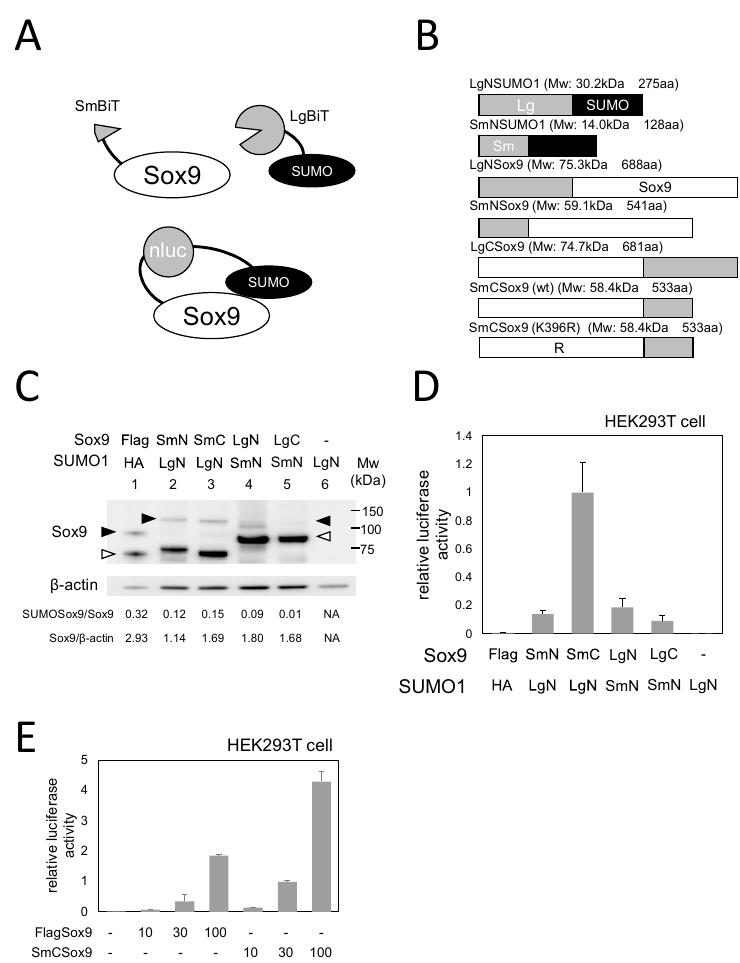
Figure 1. Generation of Small Ubiquitin-like Modifier-Sox9 (SUMO-Sox9) reporter. ( A ) Schematic diagrams of the NanoBiT reporter for detecting Sox9 SUMOylation. The upper figure indicates fusion proteins of NanoBiT fragments and Sox9 or SUMO1. The lower figure shows that the conjunction of Sox9 and SUMO1 causes the approach of SmBiT and LgBiT and, in turn, luciferase activity. ( B ) Seven types of NanoBiT fusion Sox9 and SUMO1. Gray bars indicate NanoBiT fragments. Black bars indicate SUMO1. White bars indicate Sox9. “R” in 7th construct indicates a K396R mutation. ( C ) Western blotting to investigate the expression and SUMOylation of NanoBiT fusion SUMO1 and Sox9. β -actin served as a loading control. White arrowheads indicate non-SUMOylated Sox9 and black arrowheads indicate SUMOylated Sox9. The ratios of SUMOylated / non-SUMOylated Sox9 and non-SUMOylated Sox9 / ß-actin are shown at the bottom. NA indicates that one or both protein bands was not detected. ( D ) A luciferase assay to detect the reporter activity of NanoBiT fusion SUMO1 and Sox9. Bars indicate the mean value of triplicate wells. Error bars indicate the standard deviation. ( E ) A luciferase assay to detect the transcriptional activity of wild-type and SmCSox9. Bars indicate the mean value of triplicate wells. Error bars indicate the standard deviation. All of the experiments were repeated at least twice, and representative results are shown.